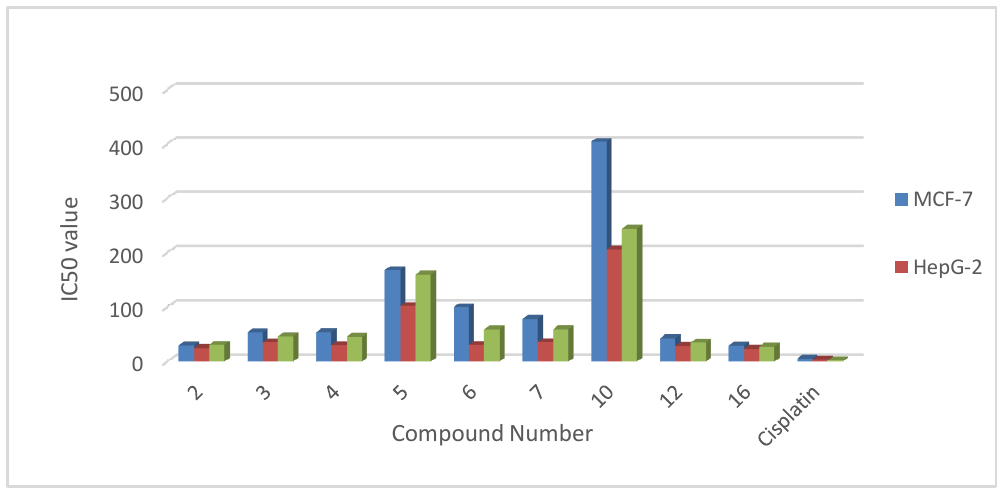
Figure 1. The anti-tumor activities of the tested compounds expressed as IC 50 values and compared with reference standard drugs evaluated on breast cancer, liver cancer, and colon carcinoma cell lines. The order of activity against the breast carcinoma cell line (MCF-7) was 16, 2, 12, 3, 4, 7, 6, 5 and 10, with IC 50 values of 29.2 ± 0.7, 29.6 ± 0.9, 43.9 ± 1.2, 54 ± 0.8, 54.5 ± 1.2, 78.2 ± 1.2, 100 ± 0.9, 145 ± 3.4, 168 ± 4.5 and 404 ± 3.4 μg/mL, respectively.